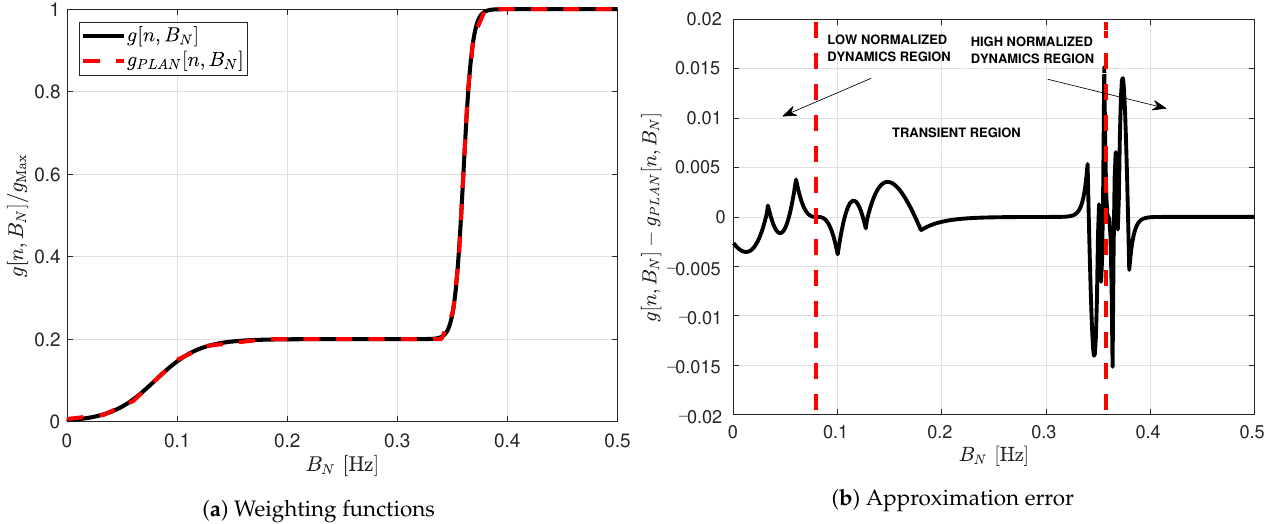
Figure 11. Comparison between sigmoid weighting function and its piecewise linear